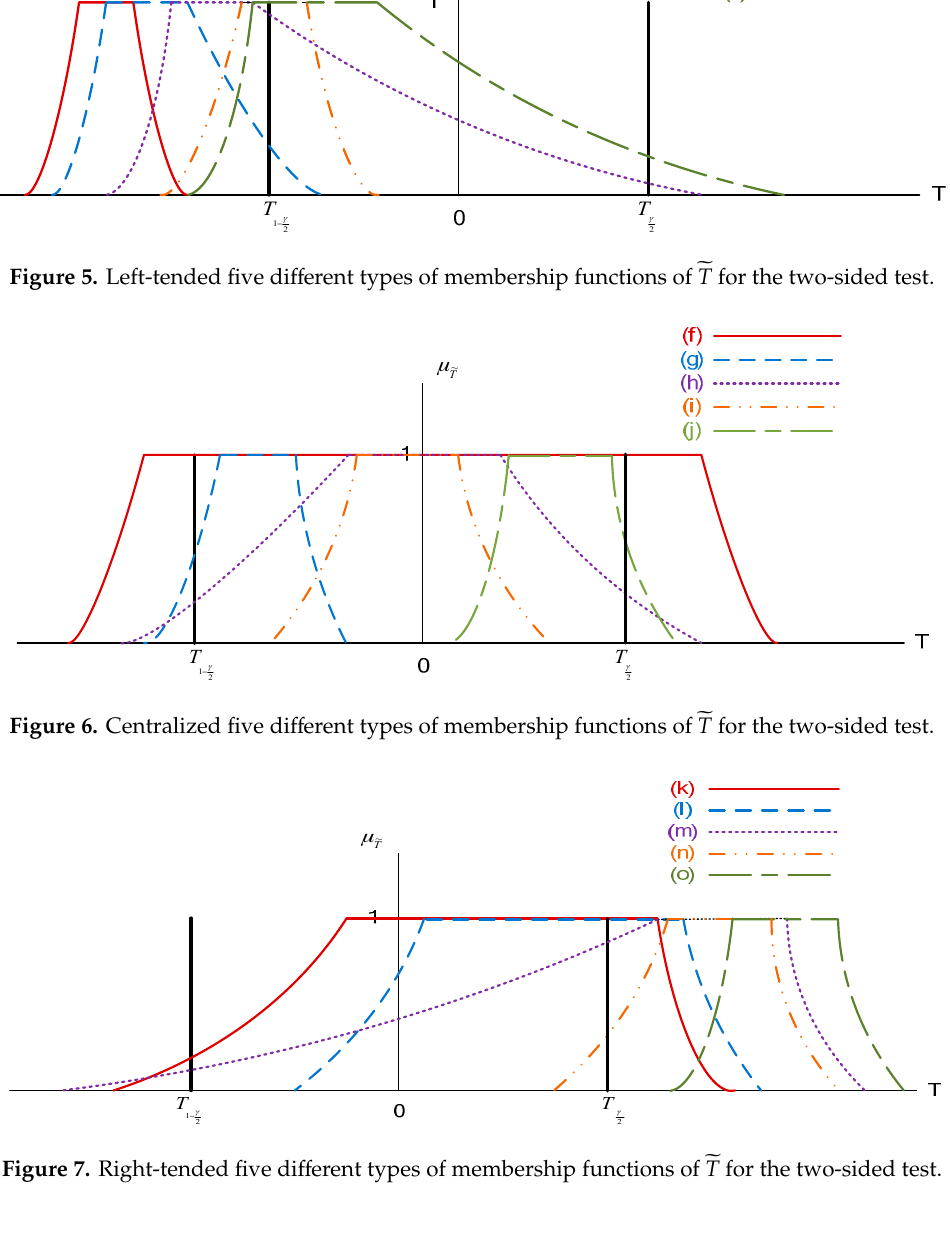
Figure 7. Right-tended five different types of membership functions of T